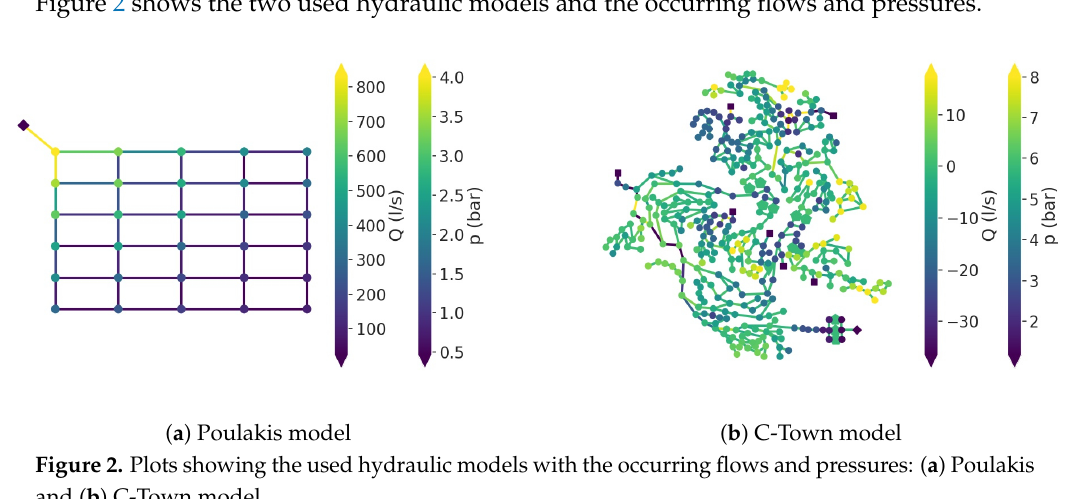
Figure 2. Plots showing the used hydraulic models with the occurring flows and pressures: ( a ) Poulakis and ( b ) C-Town